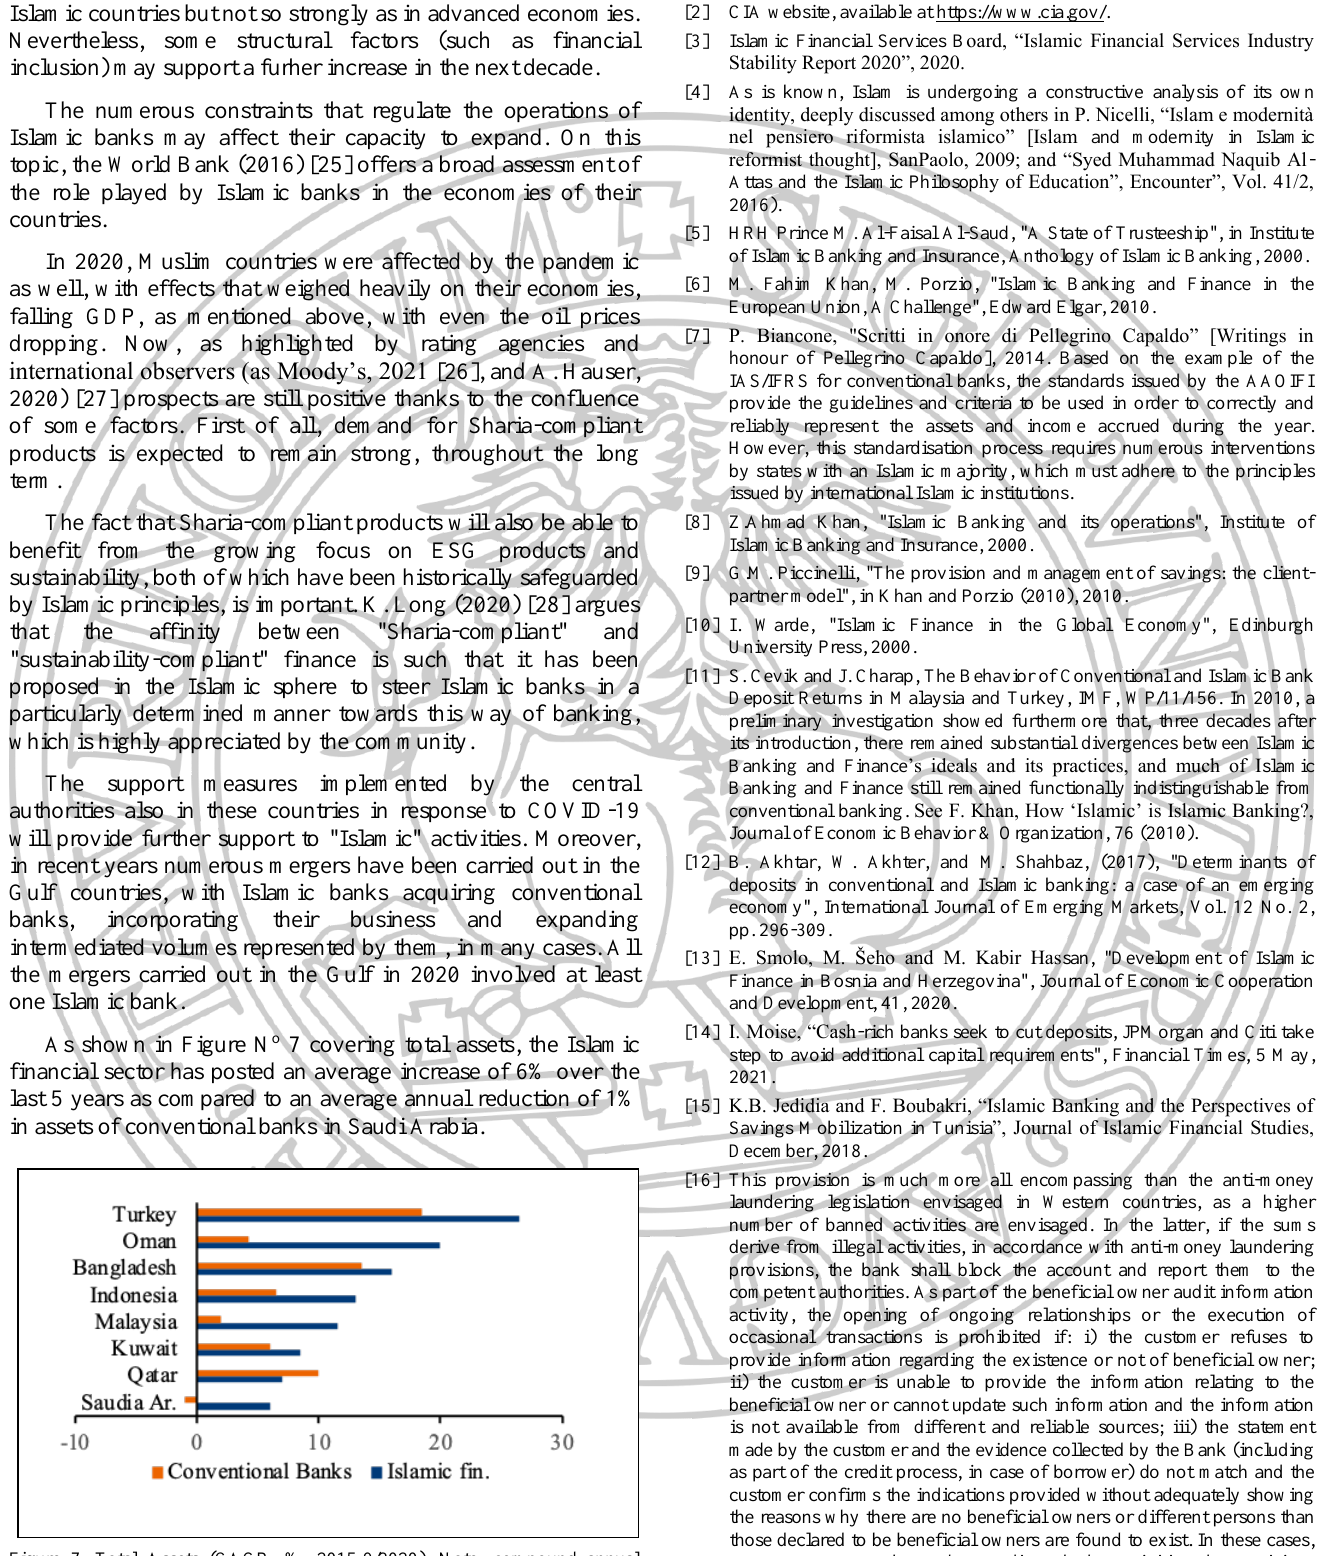
Figure 7. Total Assets (CAGR, %, 2015-9/2020). Note: compound annual growth rate. Source: